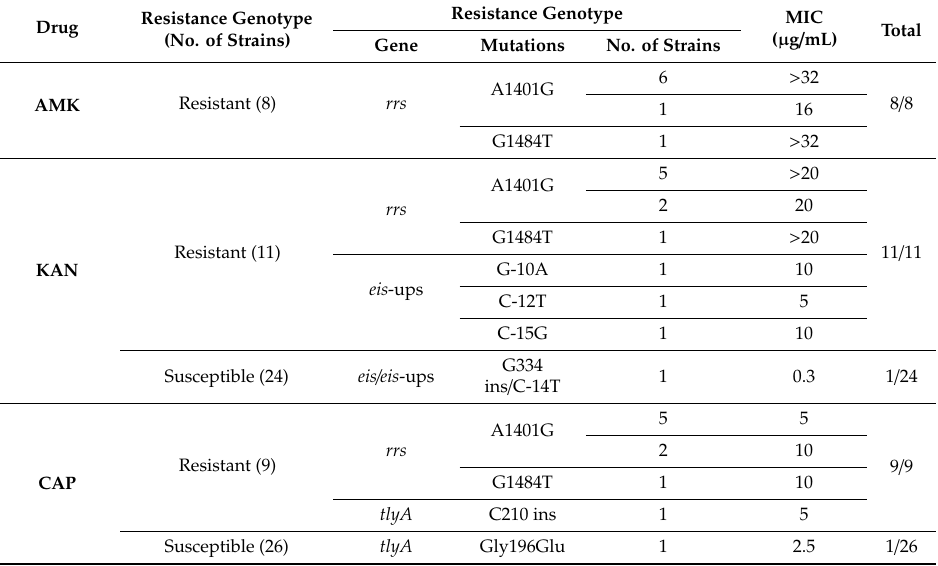
Table 4. Mutations found in genes associated with resistance for second-line injectable agents in